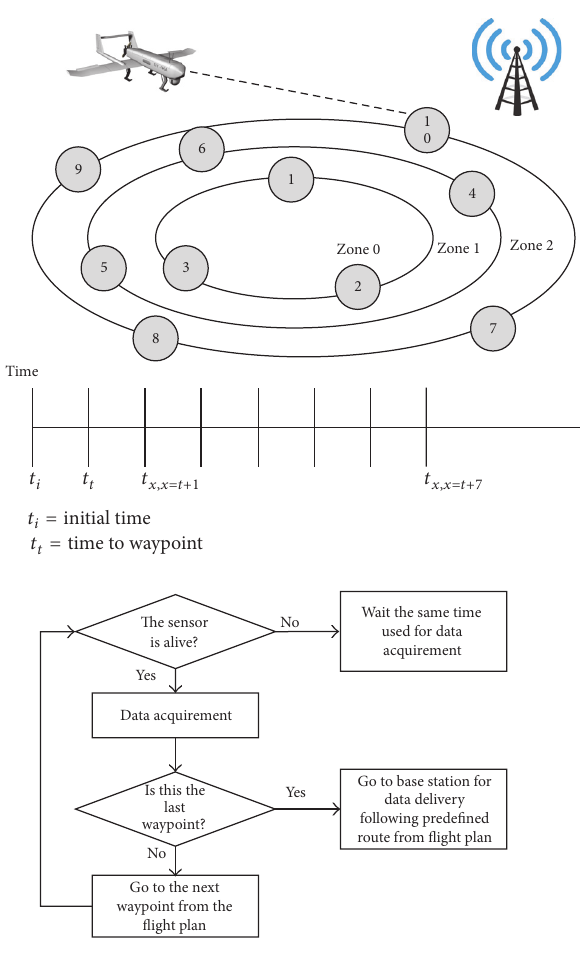
Figure 4: RPAS-sensor link.